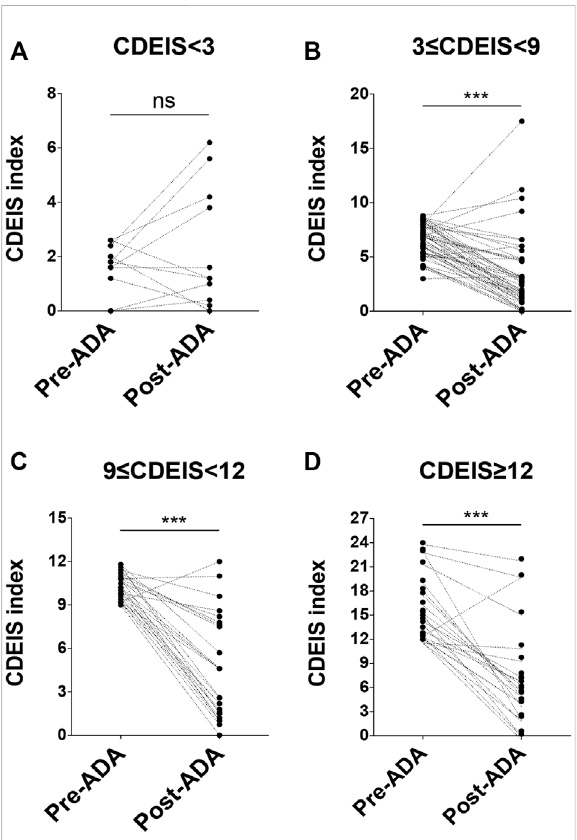
FIGURE 1 Details of patients ’ response to ADA at week 12 according to the CDEIS scores. At baseline, patients were divided into four groups. They were quiescent CD (CDEIS < 3) (A) , mildly active CD (3 ≤ CDEIS < 9) (B) , moderately active CD (9 ≤ CDEIS < 12) (C) , and severely active CD (CDEIS ≥ 12) (D) . ADA, adalimumab;